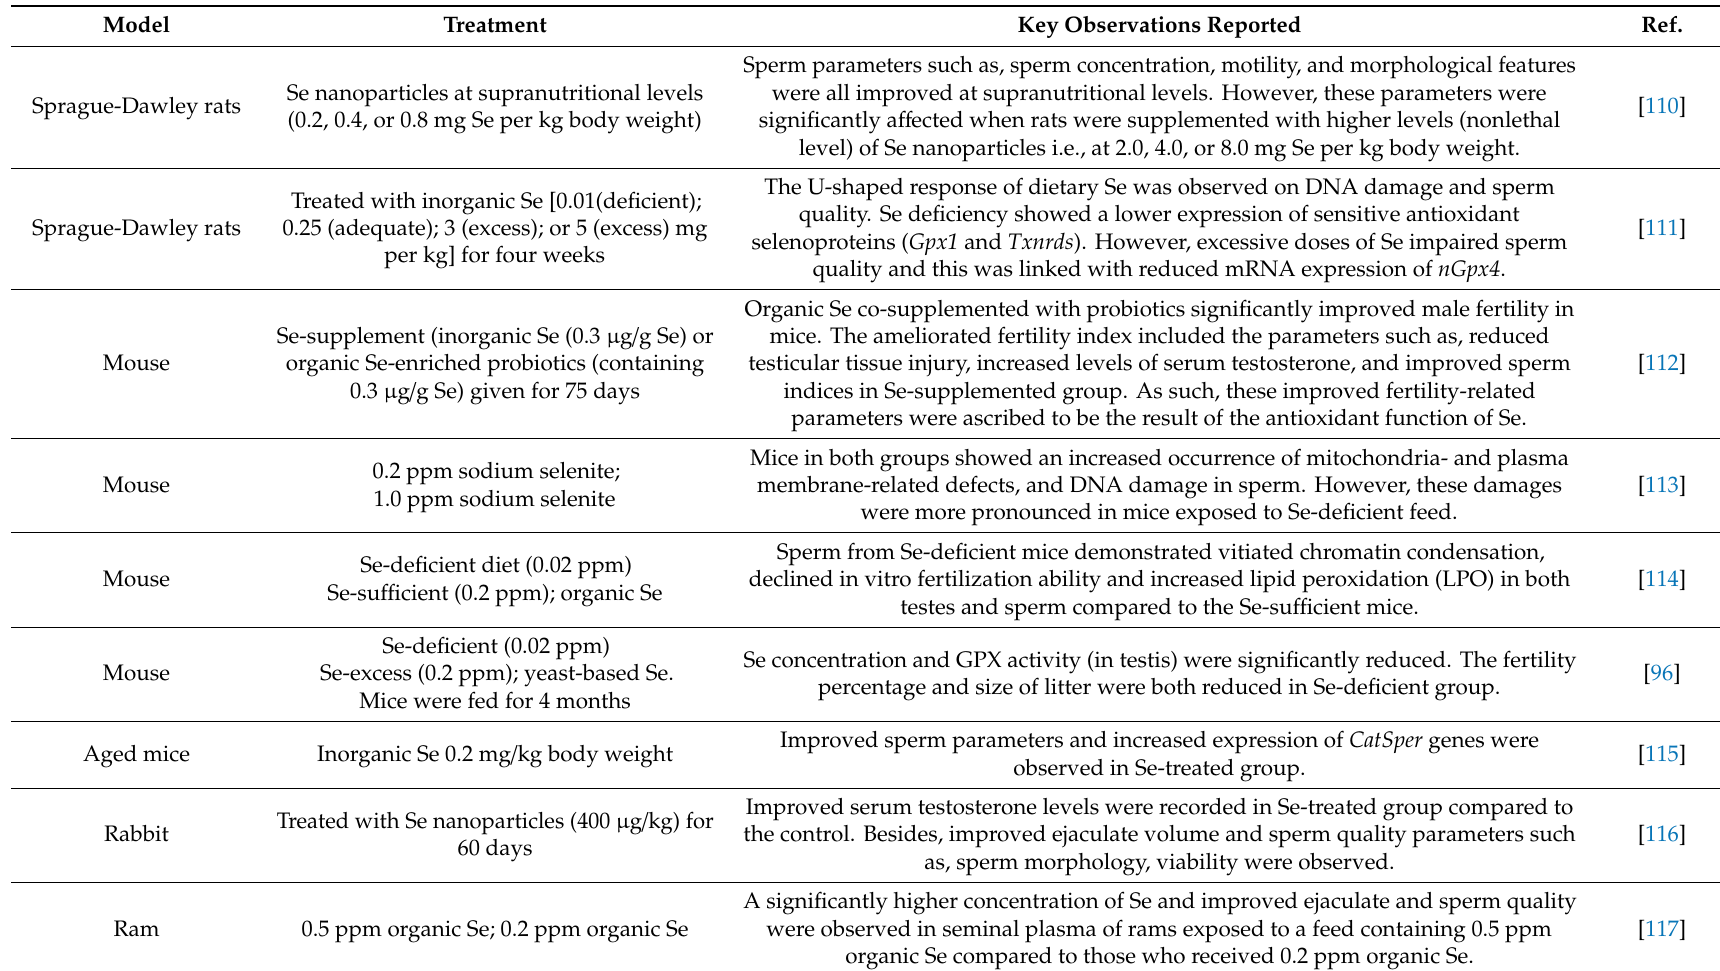
Table 4. Animal studies reporting the e ff ects of selenium supplementation on male reproductive e ffi